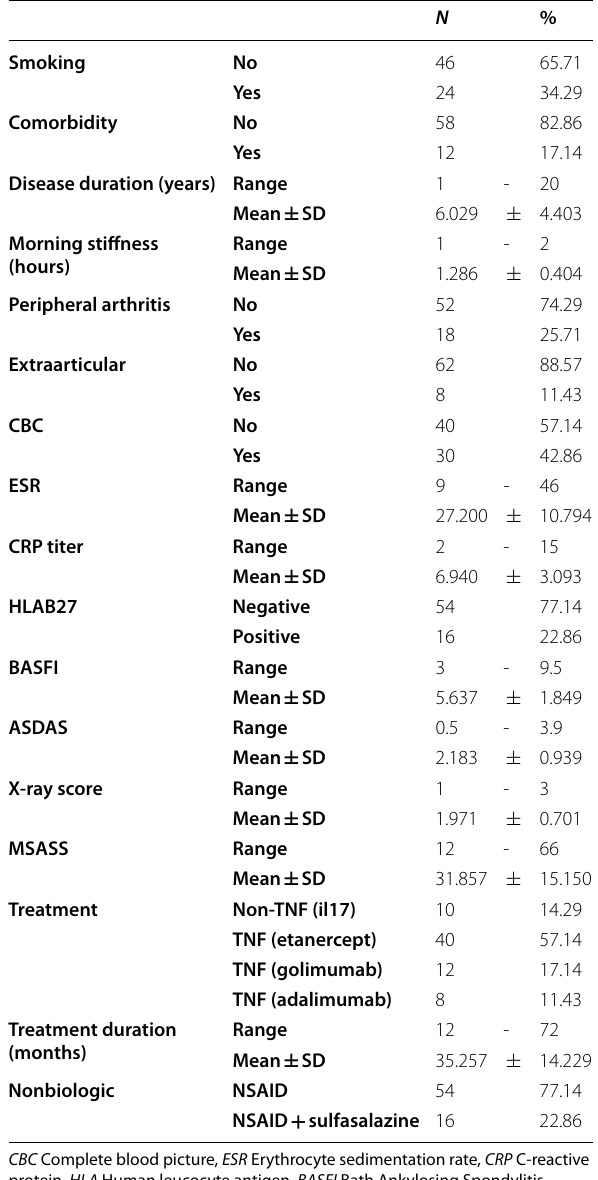
Table 2 Distribution of the sociodemographic,